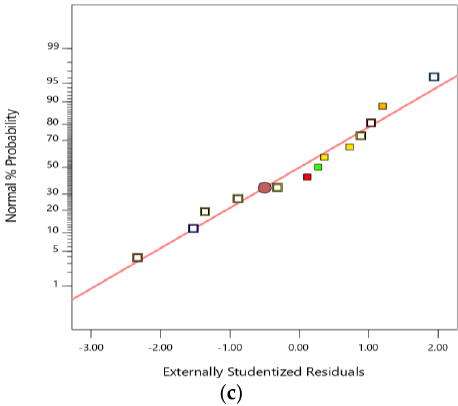
Figure 8. Normal plot versus externally studentized residuals: ( a ) 28 − day compressive strength; ( b ) 28 − day flexural strength; ( c ) 28 − day splitting tensile strength.